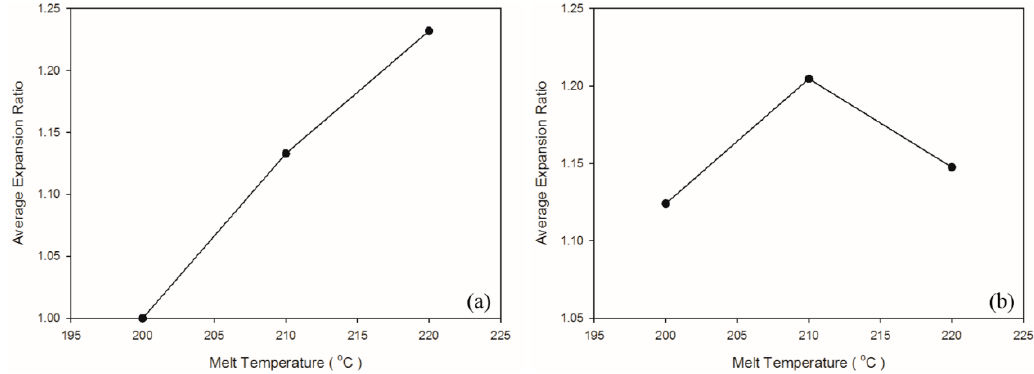
Table 7. Microscopic effects of melt temperature on the PP and PS cells as observed through the SEM.